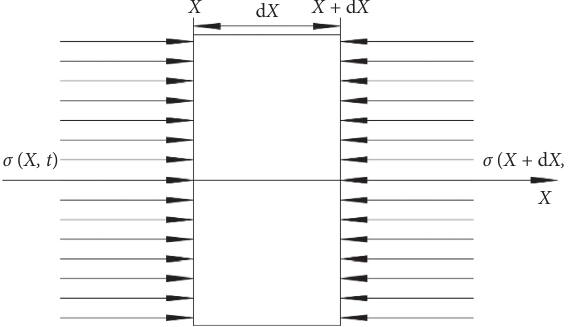
Figure 4: Stress model of sandstone microelement segment.